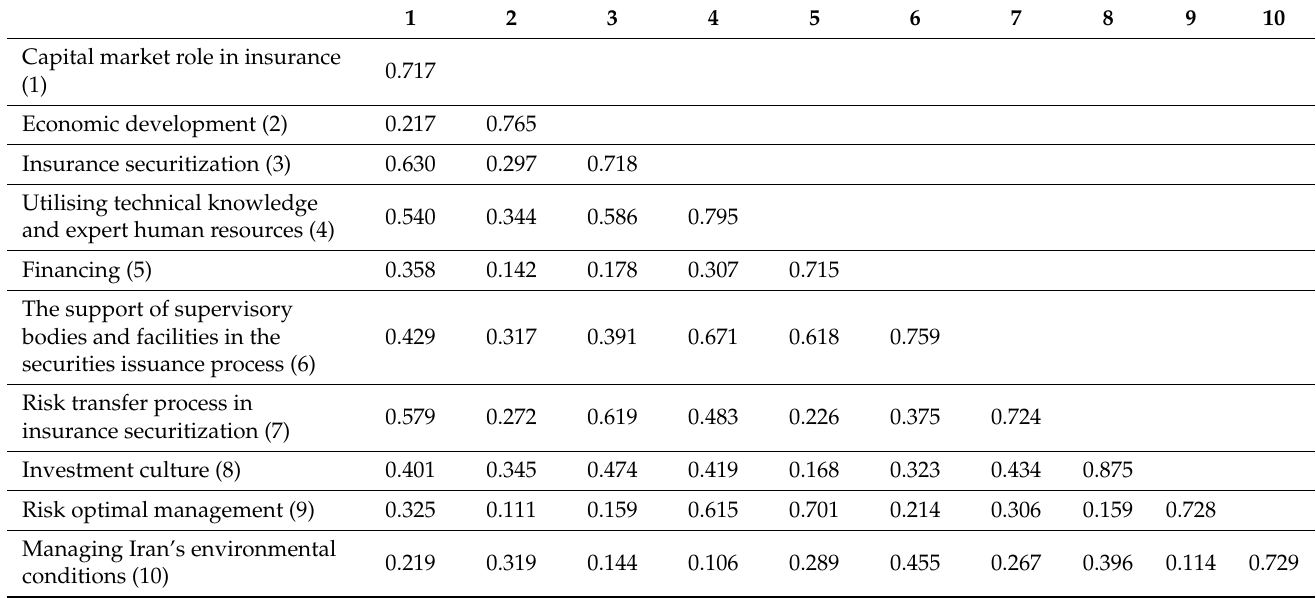
Table 4. The divergent validity matrix.